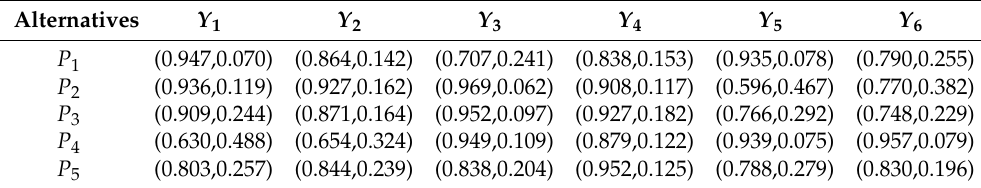
Table 5. The aggregated PyFDM of WCRCs.